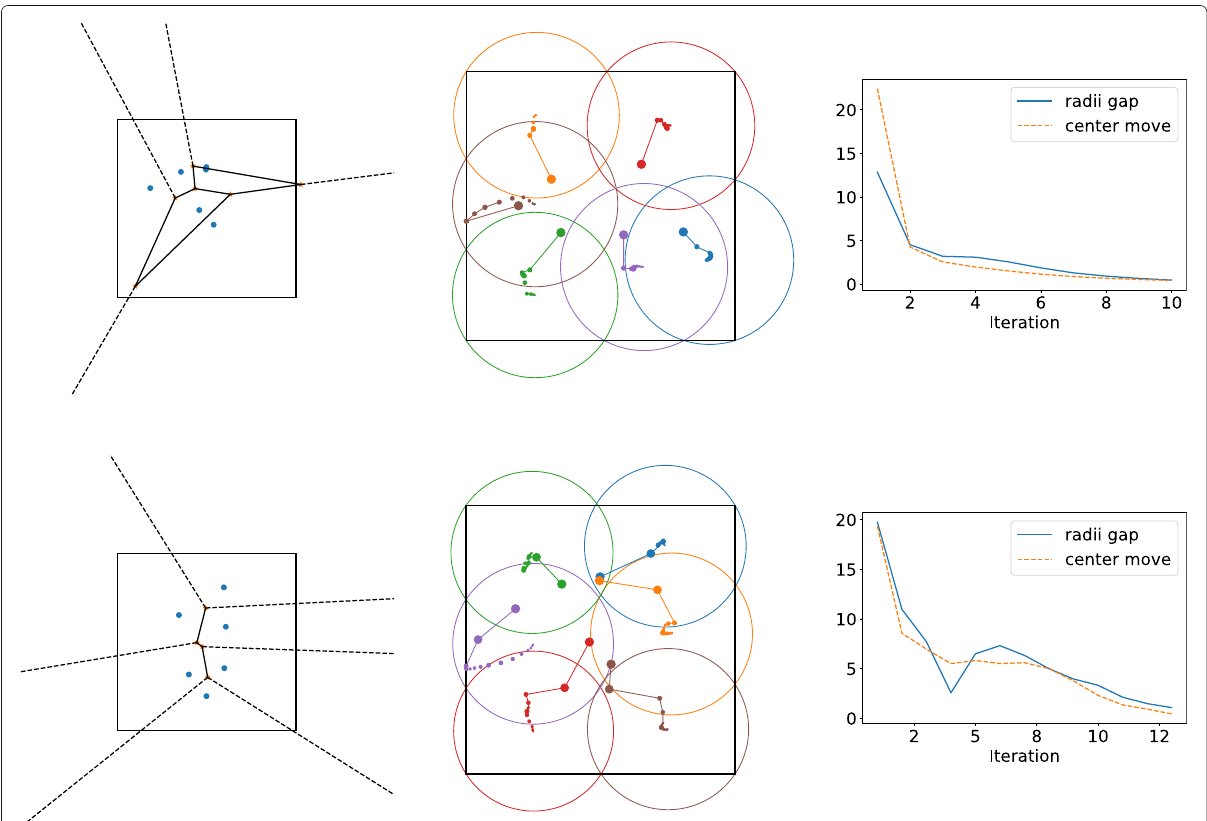
Fig. 2 Illustration of two different Voronoi heuristics solutions to the 6-center square coverage problem from two random starting points. Each row represents a solution case. The final circle radii after the finish-up step are 30.712 and 29.873, respectively. For each case from left to right: (1) Starting center locations and the corresponding Voronoi diagram; (2) Trace of the center point movements and the final circles; (3) Difference between the largest and smallest circles (radii gap) and the largest move of circle centers (center move) over the iterations that there are not many unique solutions that the random- starting Voronoi heuristics is capable of identifying. For example, 100 runs of the Voronoi heuristics on the same problem as shown in Fig. 2 produced only six unique (up to the 7th digit after the decimal point) objective